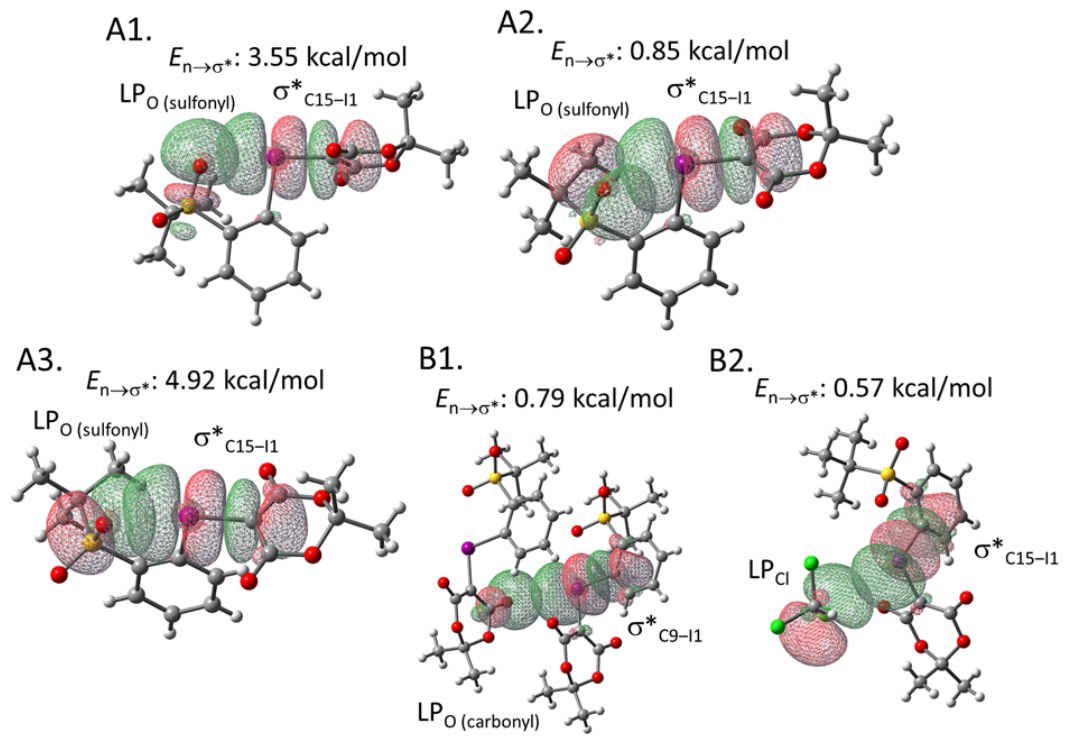
Figure 4 . NBO analysis of iodonium ylide 2g . ( A1 ) Intramolecular XB between a lone pair of the sulfonyl group (Orbital#58) and the C15-I1 σ * orbital (Orbital#123) (type 1). ( A2 ) Intramolecular XB between a lone pair of the sulfonyl group (Orbital#105) and the C15-I1 σ * orbital (Orbital#123) (type 2). ( A3 ) Intramolecular XB between a lone pair of the sulfonyl group (Orbital#104) and the C15-I1 σ * orbital (Orbital#123) (type 3). ( B1 ) Intermolecular XB between a lone pair of the carbonyl group and the C9-I1 σ * orbital. ( B2 ) Intermolecular XB between a lone pair of the Cl group and the C9-I1 σ * orbital.